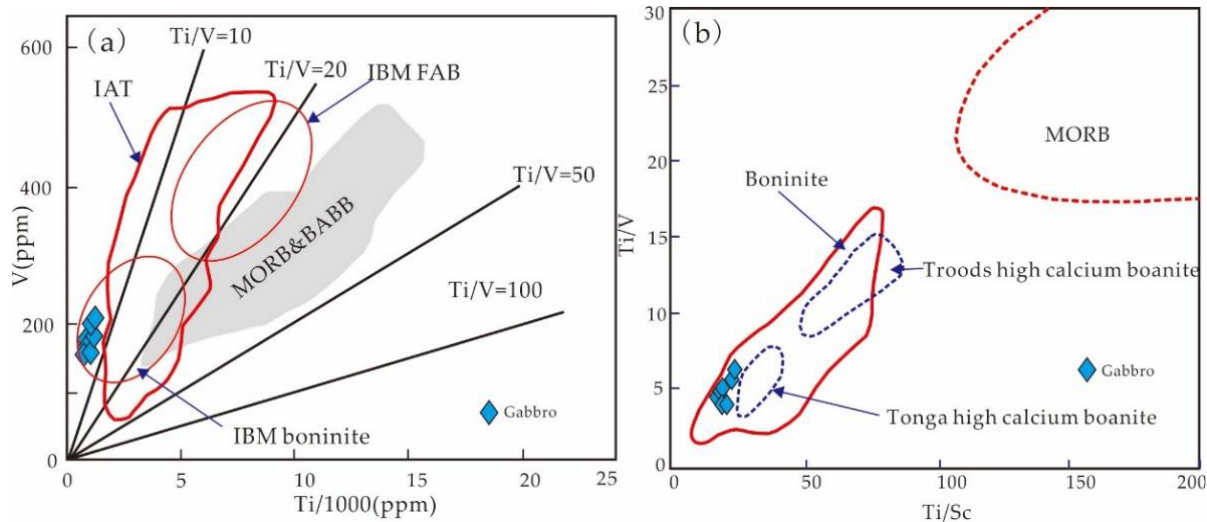
Figure 11. ( a,b ) Discrimination diagrams of gabbro tectonic environment, Laguoco, Tibet, modified after [57].